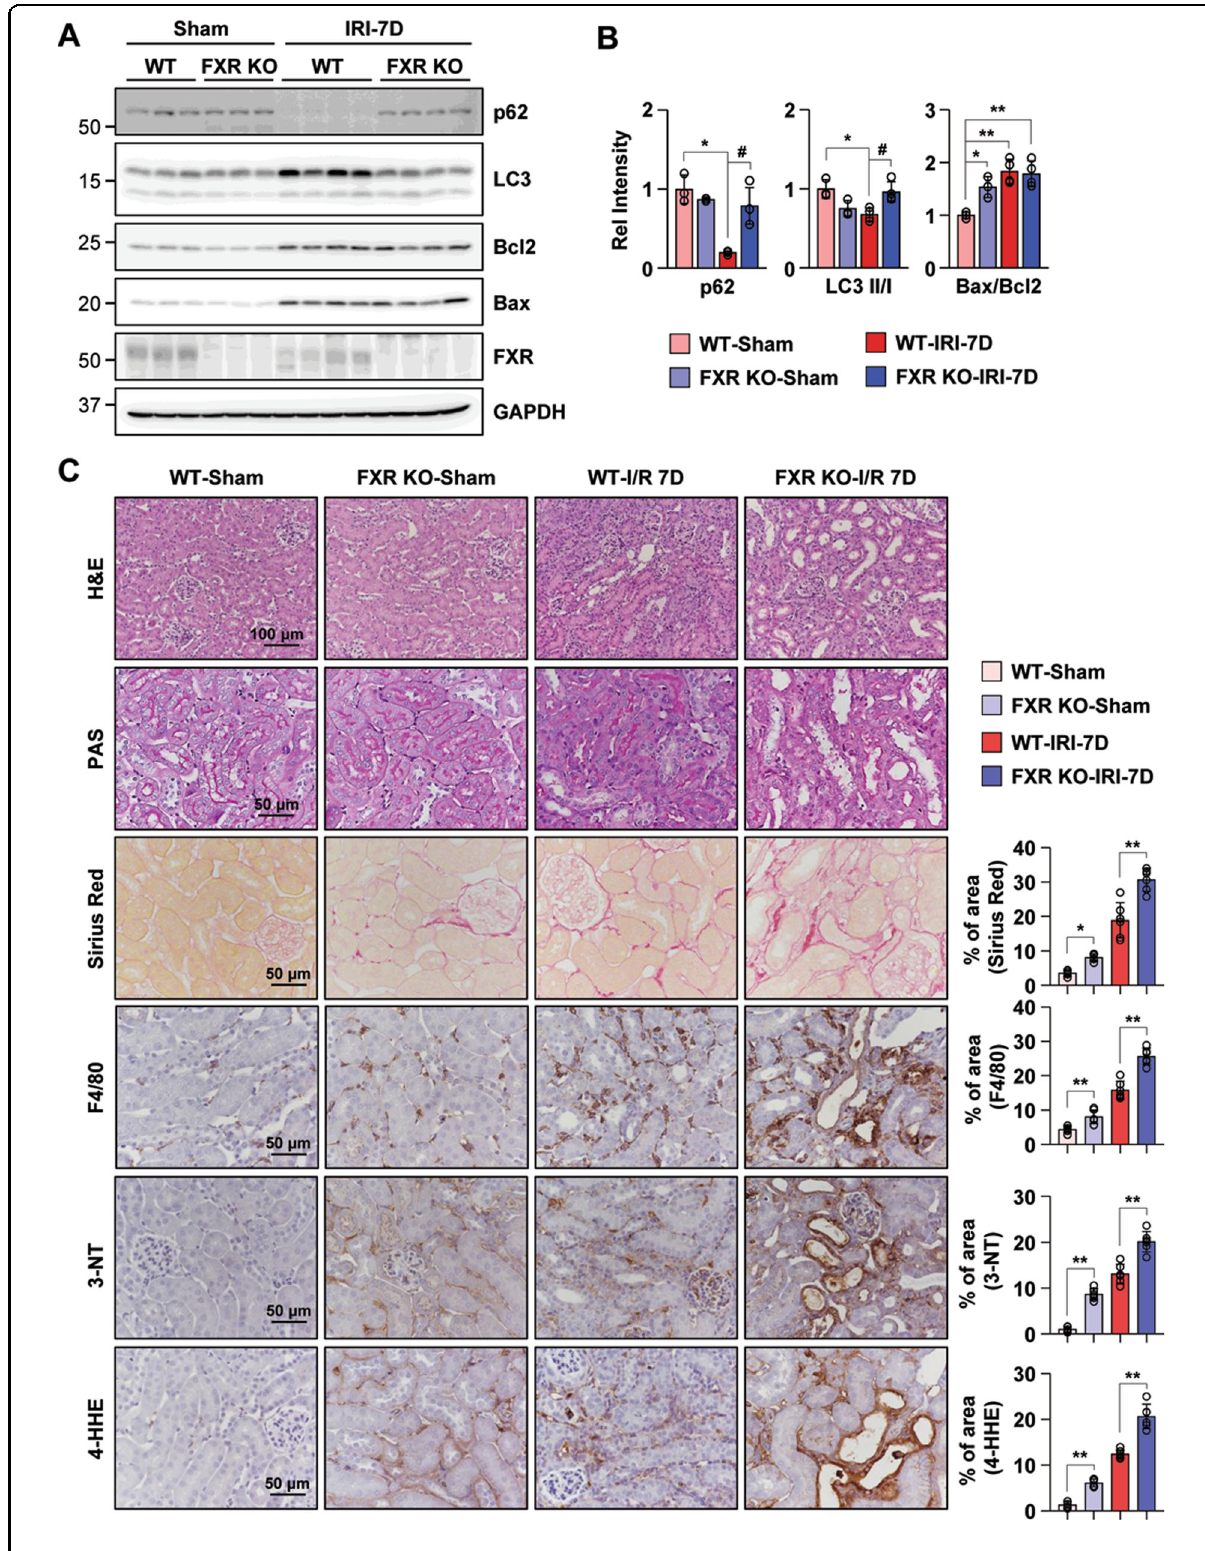
Fig. 7 (See legend on next